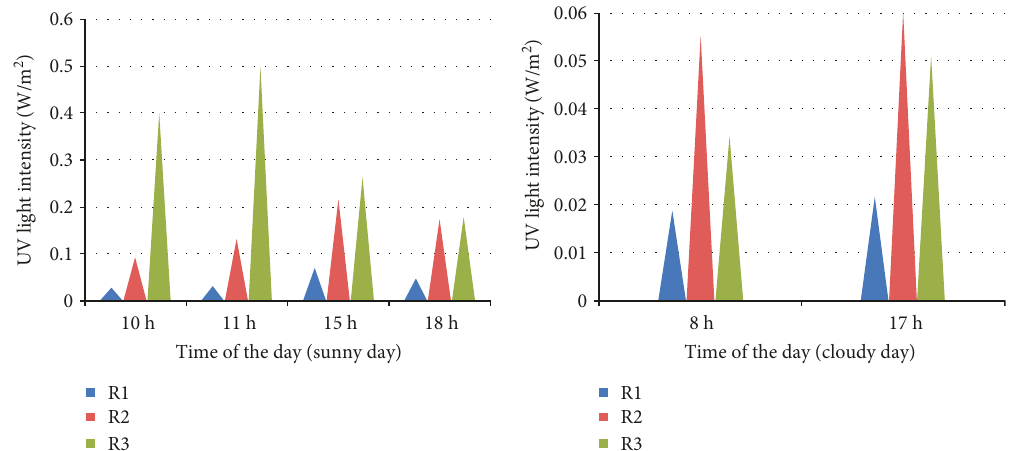
Figure 7: UV light intensity available during daytime in three rooms (not under direct sunlight): a laboratory room (R1) and two classrooms (R2 and R3) on sunny and cloudy days in April in Toulouse, south of France (beware of the y -axis scale on the